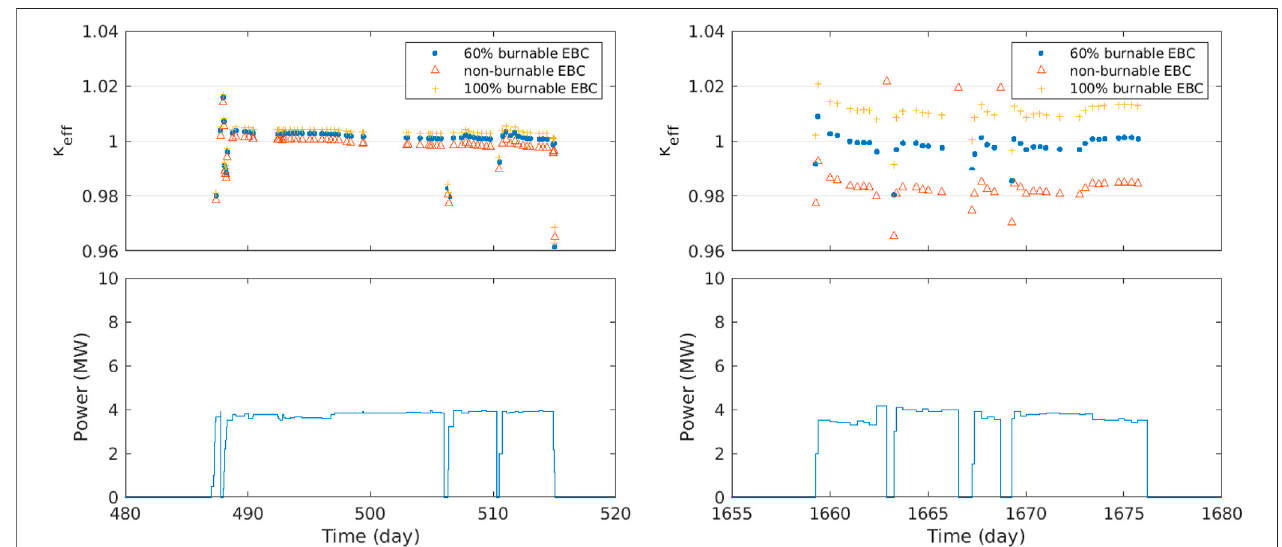
FIGURE 9 | In fl uence of the EBC burnup